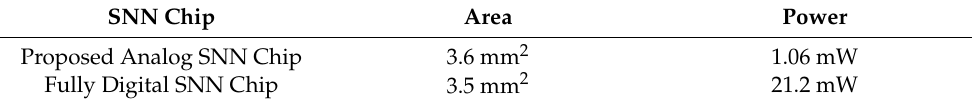
Table 2. Comparison between the Proposed Analog SNN and Fully Digital